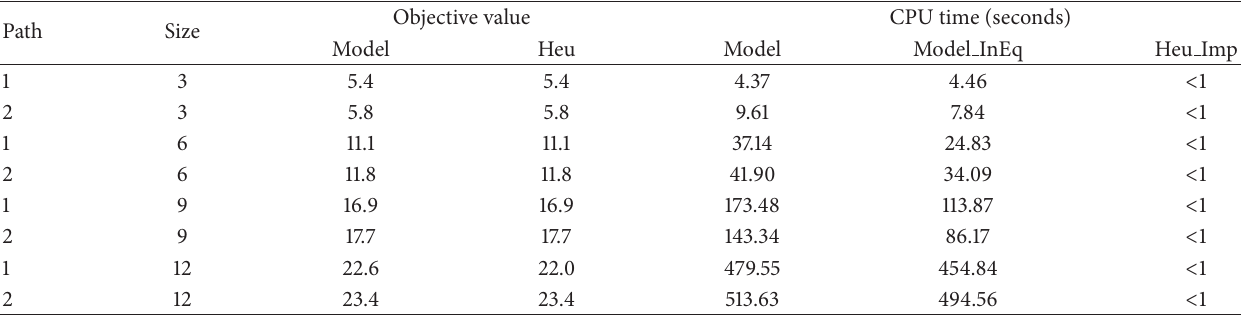
Table 2: Experiment result for the small sized problems.